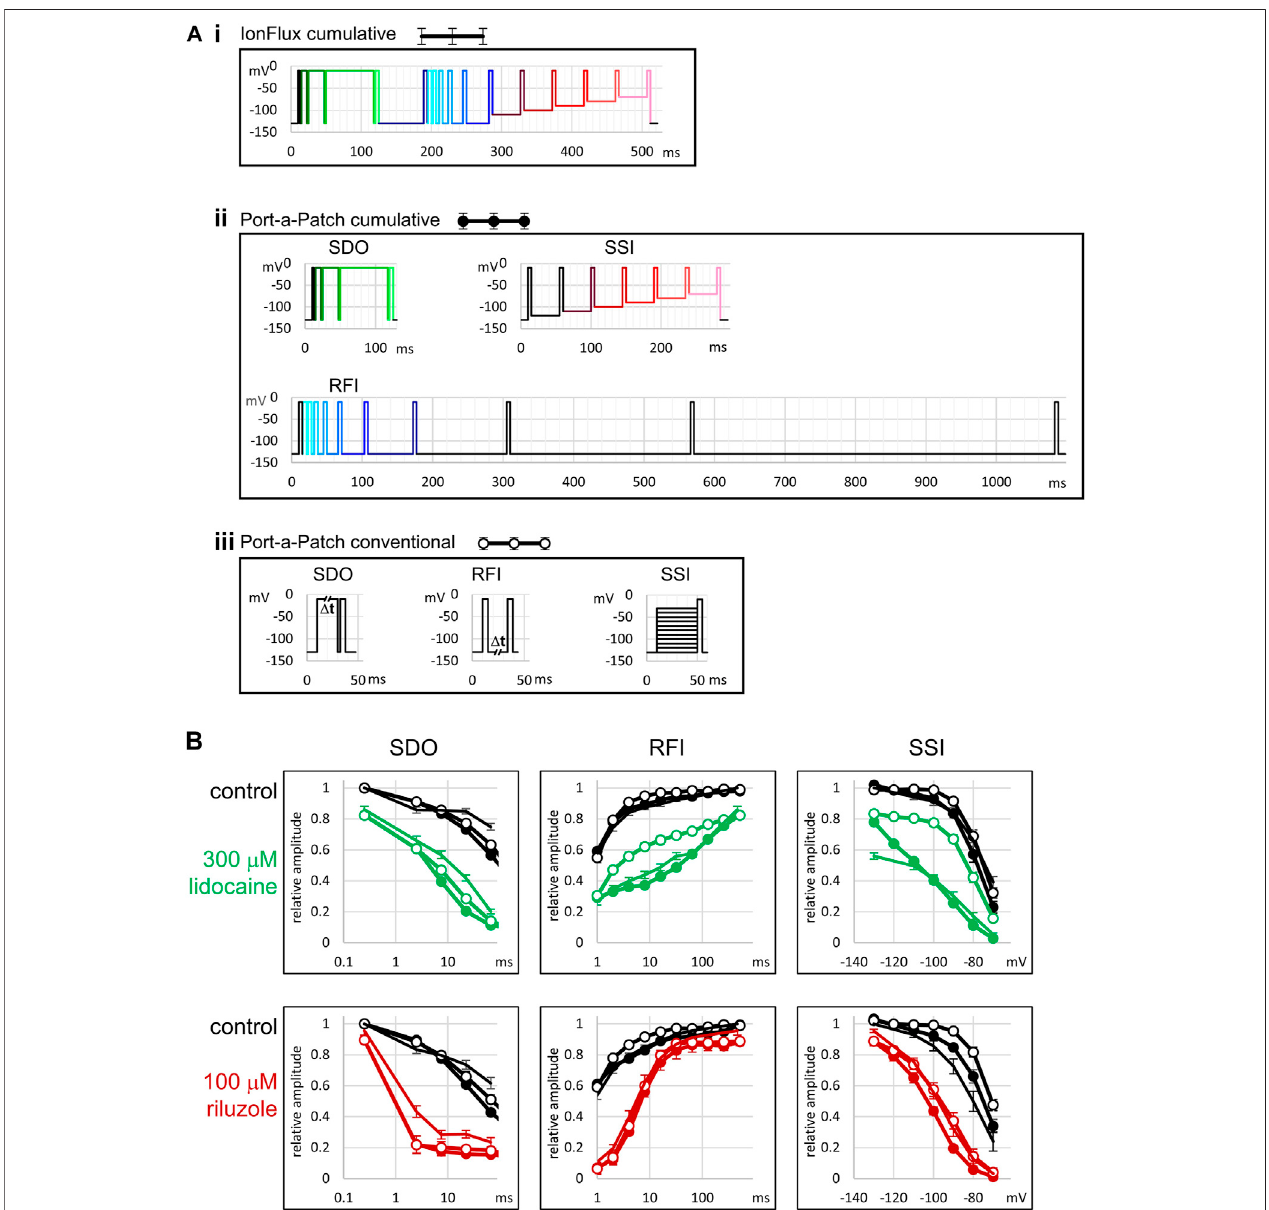
FIGURE 2 | Comparison with single-cell electrophysiology, and with conventional protocols. (A) Illustration of the voltage protocols under three different experimentalconditions. (i) The17-pulsecumulativeprotocolusedinIonFluxexperiments,asdescribedin Figures1 , 3 . (ii) ThethreecumulativeprotocolsusedinPort- a-Patch experiments. Colors ofpulses indicate correspondingpulses inthe IonFlux protocol. The SDO protocol wasexactly the same asin the IonFlux protocol The SSI section contained an extra 40 ms interpulse interval at − 120 mV. The interpulse intervals of the RFI section were: 1, 2, 4, 8, 16, 32, 64, 128, 256, and 512 ms. In contrast,theinterpulseintervalsintheIonFluxprotocolwere:1,2,4,8,16,32,64 ms(precedingtheshorterintervals),and498 ms(timebetweensweeps). (iii) Thethree conventionalprotocolsusedinPort-a-Patchexperiments. (B) Resultsobtainedbytheprotocols.Thisseriesofexperimentswasdesignedtoaddresstwoquestions:Are there differences between results obtained using ensemble recordings (IonFlux — lines with no circles) and single-cell recordings (Port-a-Patch — lines with closed circles)? Are there differences between results obtained using cumulative (Port-a-Patch — lines with closed circles) and conventional (Port-a-Patch — lines with open circles) protocols? Black color indicates control in all fi gures; Green — 300 µM lidocaine; Red — 100 µM riluzole.